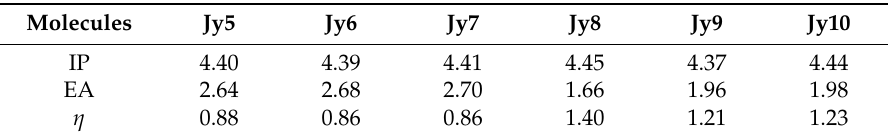
Table 2. The ionization potential (IP) (eV), electron affinities (EA) (eV) and absolute hardness η (eV) of six investigated